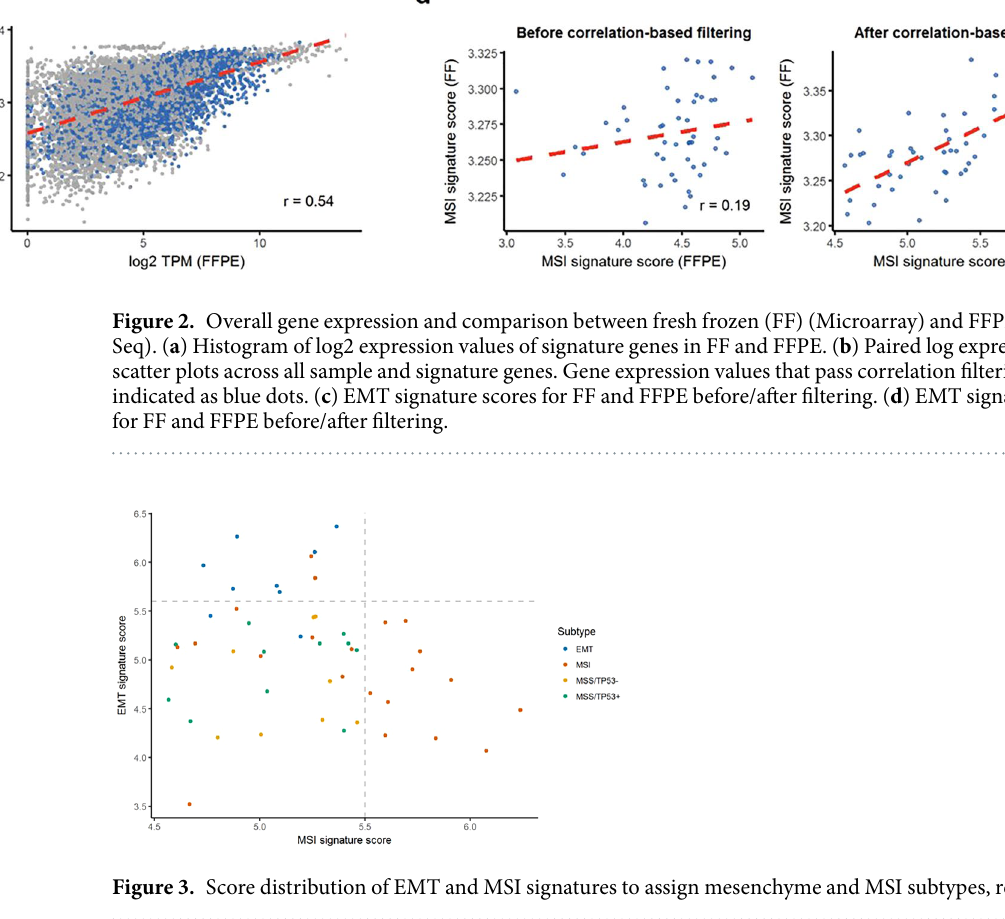
correlations for EMT and MSI signature scores between two platforms were 0.66 and 0.19, respectively (Fig. 2c,d, left). The TP53 signature is composed of two genes CDKN1A and MDM2, for which the Pearson correlations between two platforms were 0.54 and 0.33, respectively (Fig. S4).